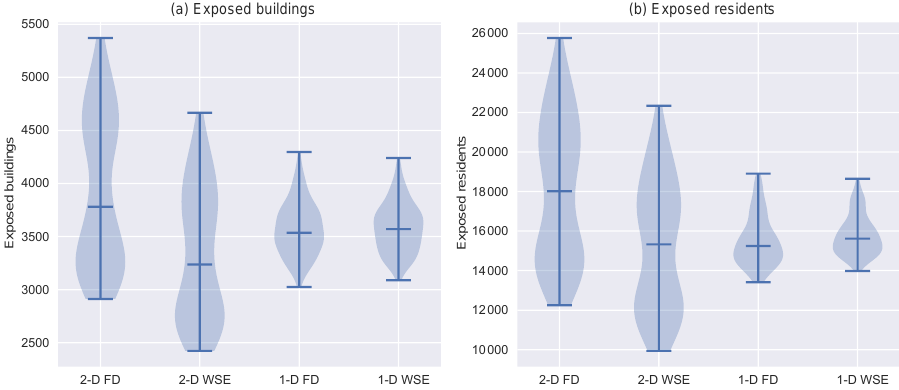
Figure 5. Exposed buildings (a) and residents (b) aggregated at river basin level. Flood losses aggregated at river basin level. The variation between the PMP scenarios is shown on the y axis, whereas the x axis shows the variability inherent to the choice of the flood model (2- D: LISFLOOD-FP; 1-D: BASEMENT-1D) in combination with the approach for attributing flow depths to the buildings (FD: flow depths are calculated on the basis of flow depths maps; WSE: flow depths are calculated on the basis of water surface elevation maps and the object-specific ground floor